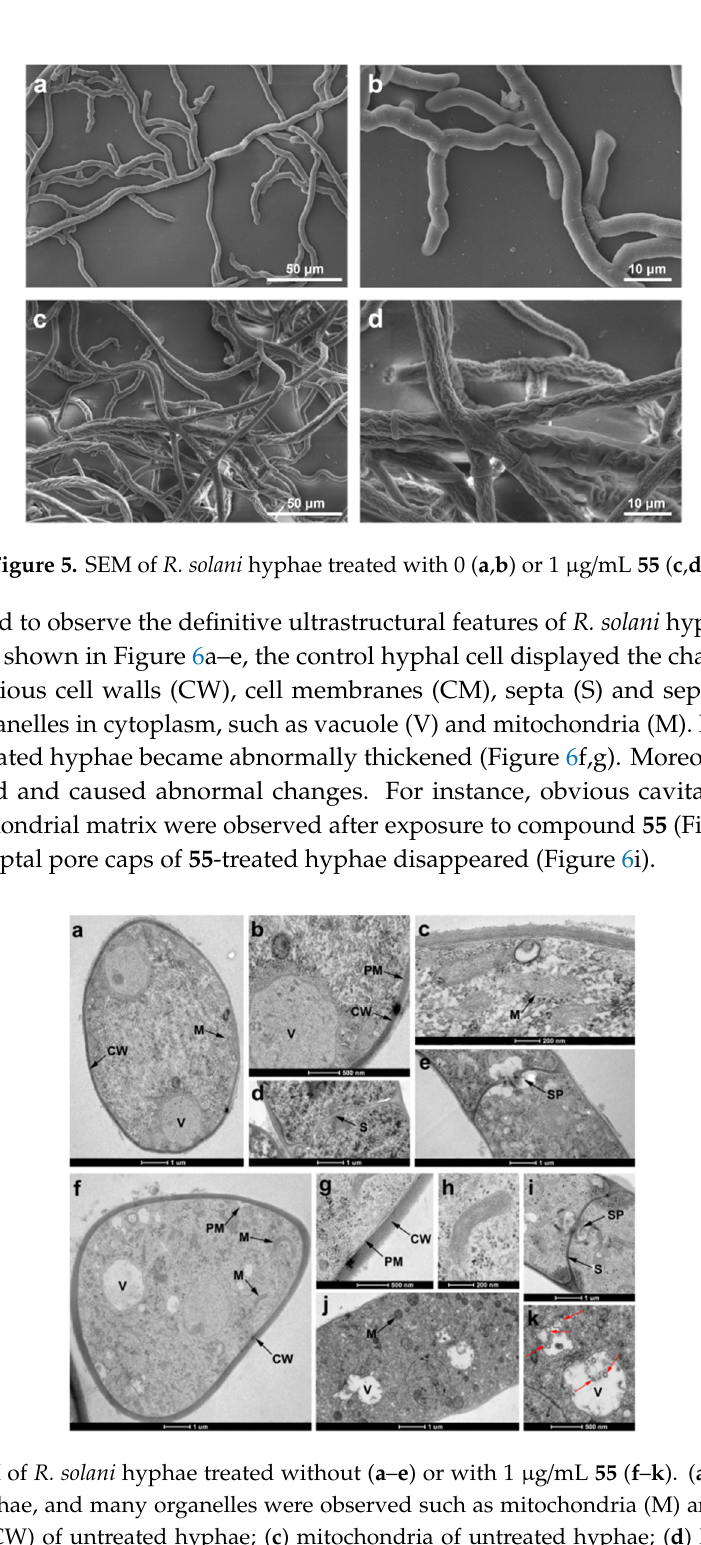
Figure 6. TEM of R. solani hyphae treated without ( a – e ) or with 1 µ g / mL 55 ( f – k ). ( a ) transverse of untreated hyphae, and many organelles were observed such as mitochondria (M) and vacuole (V); ( b ) cell wall (CW) of untreated hyphae; ( c ) mitochondria of untreated hyphae; ( d ) longitudinal of untreated hyphae, and spectra (S) and was uniform; ( e ) septal pore caps (SP) of untreated hyphae was visible; ( f , g ) transverse of 55 -treated hyphae, and cell wall was thickening; ( h ) mitochondria of 55 -treated hyphae was swollen; ( i ) longitudinal of 55 -treated hyphae, and the septal pore caps disappeared; ( j , k ) longitudinal of 55 -treated hyphae (loss of matrix in vacuoles and obvious vacuolization), and red arrow represented